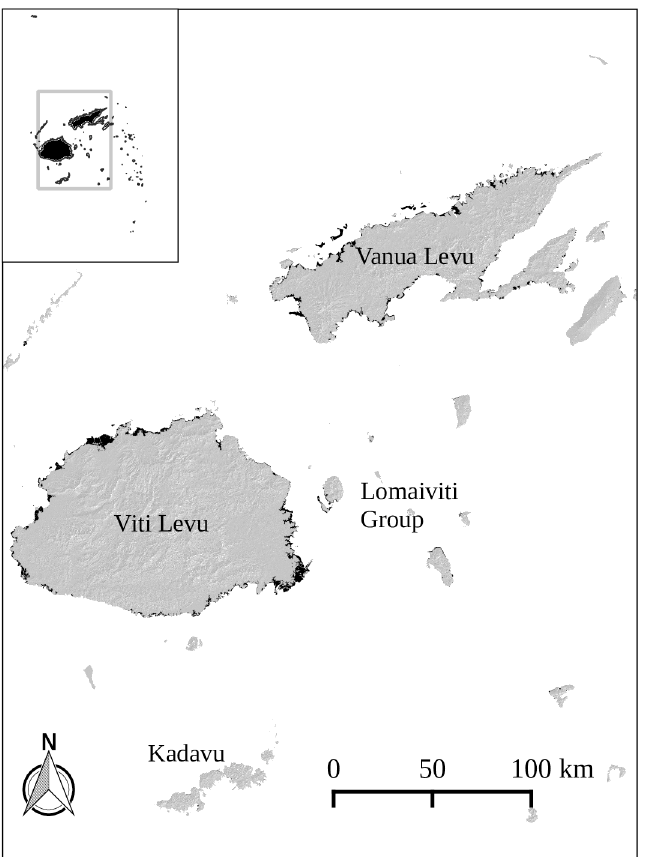
Fig 1. Central areas of the Fijian Archipelago (inset). Greater than 95% of Fiji's mangrove areas occur on the islands of Viti Levu, Vanua Levu, Kadavu, and within the Lomaiviti Group. Dark polygons are mangrove areas mapped in this